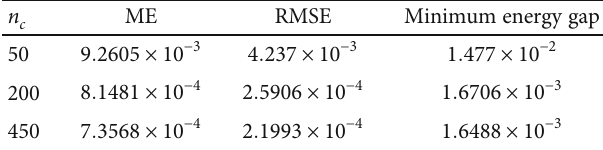
Table 2: Comparing the accuracy with di ff erent n